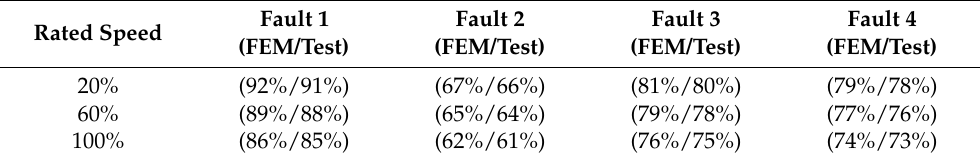
Table 5. Torque limitation for fault